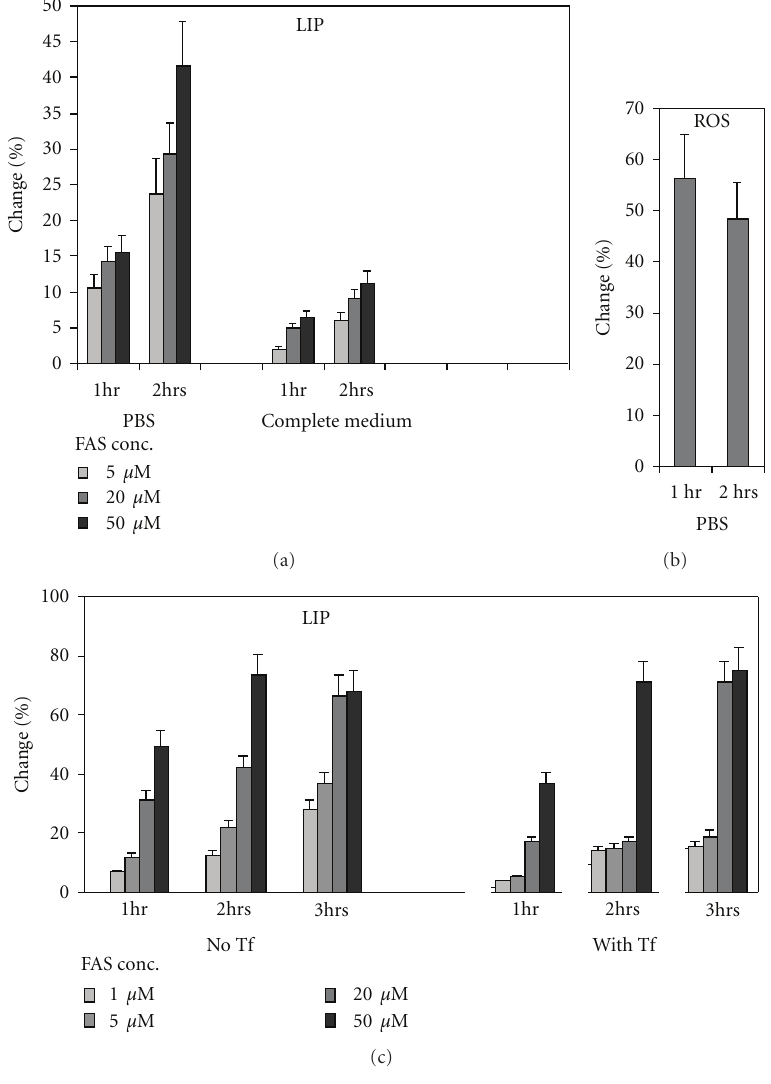
Figure 3: The e ff ect of transferrin (Tf) on iron uptake and ROS by cultured erythroid precursors. Cultured human erythroid precursors were harvested on days 7-8 of phase II, washed and loaded with CA or DCF. (a) CA-loaded cells were washed and resuspended in PBS or in phase II medium (complete medium, containing 30% serum), and incubated for 1- or 2hrs with the indicated concentrations of FAS. (b) DCF-loaded cells were washed and resuspended in PBS, and incubated for 1- or 2hrs with the indicated concentrations of FAS. (c) CA-loaded cells were washed and resuspended in PBS supplemented with or without human holo-Tf (300 μ g/mL) and incubated for 1–3 hrs with the indicated concentrations of FAS. The results indicated reduced iron uptake in the presence of Tf. The results are expressed as the percent (%) change (mean ± SD, N = 4) in the MFIs following incubation with and without Fe, calculated per the MFI −